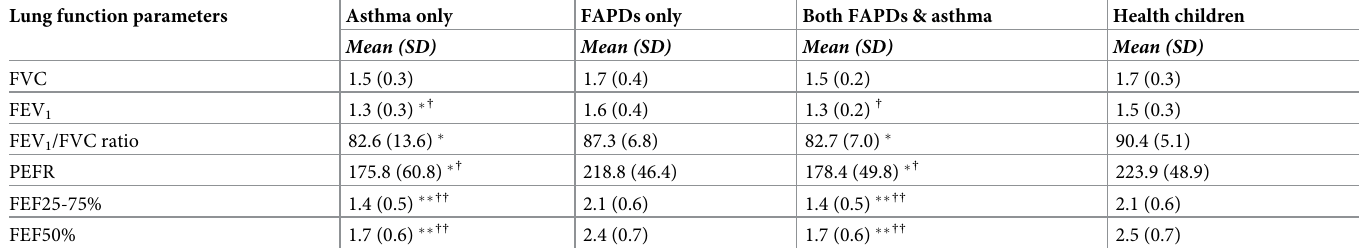
Table 3. Comparison of lung function parameters between study groups. Lung function